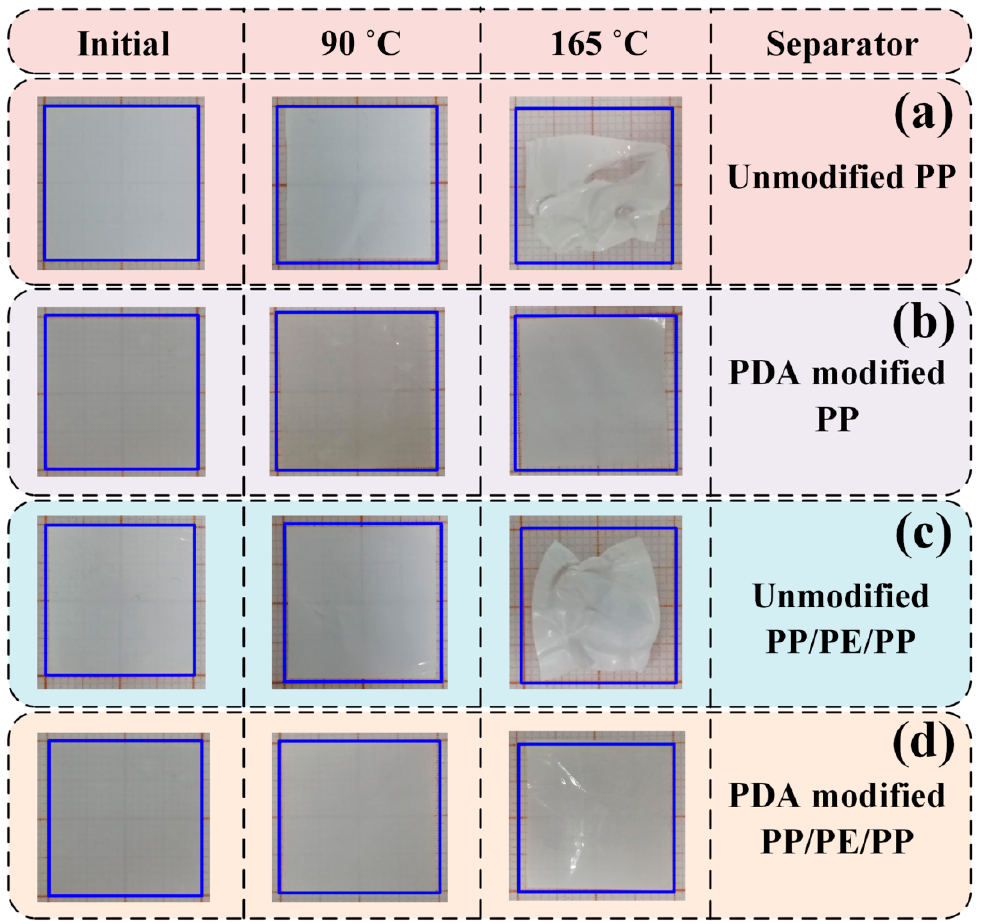
Figure 7. The changes of thermal shrinkages of separators with temperature: (a) unmodified PP; (b) PDA-modified PP; (c) unmodified PP/PE/PP; (d) PDA-modified PP/PE/PP.